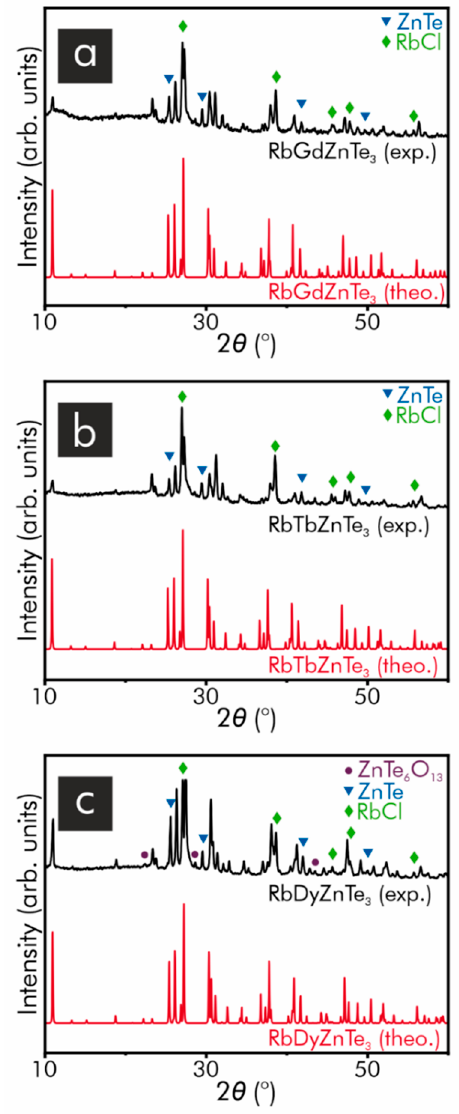
Figure 1. Measured and simulated powder X-ray di ff raction patterns of ( a ) RbGdZnTe 3 , ( b ) RbTbZnTe 3 , and( c )RbDyZnTe 3 : reflectionsarisingfromtheside-productsRbCl[33], ZnTe[34], andZnTe 6 O 13 [35]are marked by the diverse symbols. A closer inspection of the measured powder X-ray di ff raction patterns also points to the presence of additional reflections (~25 ◦ ), which correspond to unknown